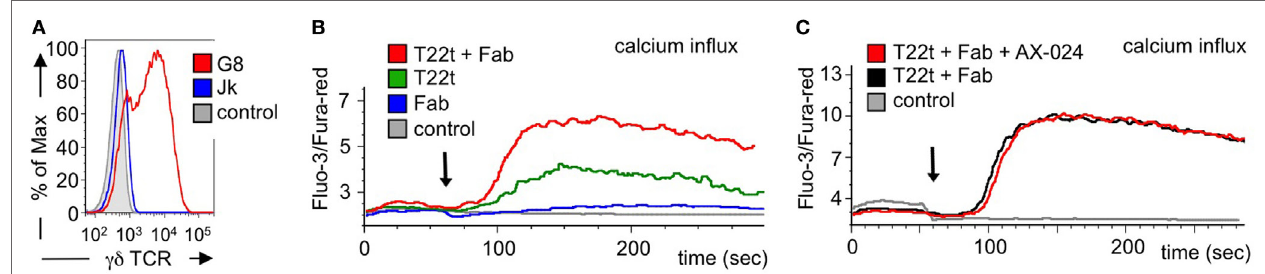
FigUre 8 | Calcium signaling is enhanced by Fab fragments and does not require the Nck- γδ T cell antigen receptor (TCR) interaction. (a) G8 γδ TCR-expressing Jurkat cells were stained with the γδ TCR-specific antibody GL3 and analyzed by flow cytometry. As controls, the GL3-stained parental Jurkat cells and unstained G8 γδ TCR-expressing cells are shown ( n > 3). (B) Jurkat cells expressing the G8 γδ TCR were stimulated with the G8 ligand T22 tetramers (T22t), UCHT1 Fab, or a combination of both T22t and Fab. Intracellular calcium was measured using the dyes Fluo-3 and Fura-red by flow cytometry. Calcium influx is depicted as the median ratio of Fluo-3 to Fura-red fluorescence over time. As a negative control, steptavidin was added to the cells. The arrow indicates addition of the stimuli ( n = 3). (c) The experiment was performed as in (c) with the difference that cells without and with 10 nM AX-024 were stimulated with the combination of T22t and Fab. As a control, PBS was added to the cells ( n =